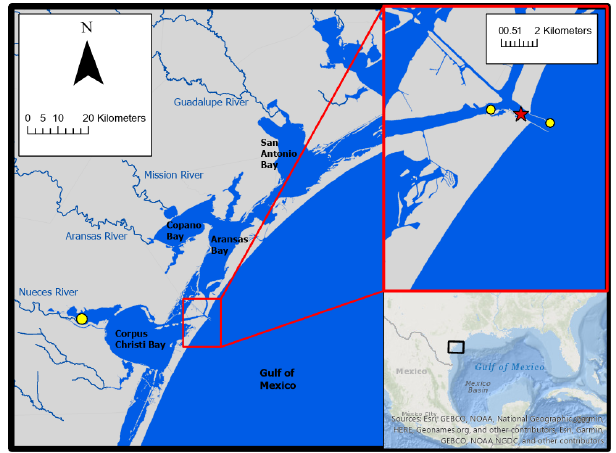
Figure 1. Study area. The location of monitoring in the Aransas Ship Channel (red star) and the locations of NOAA stations used for wind data (yellow circles) are